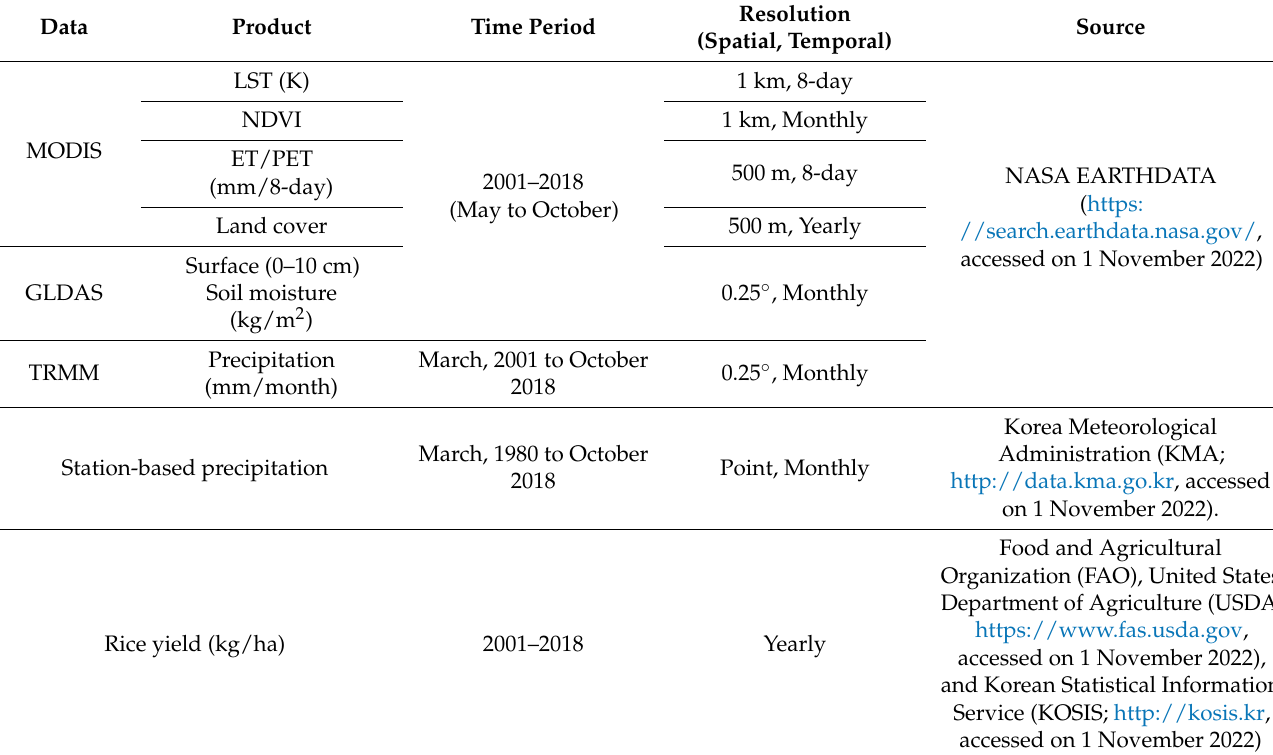
Table 1. Specification of the datasets used in this